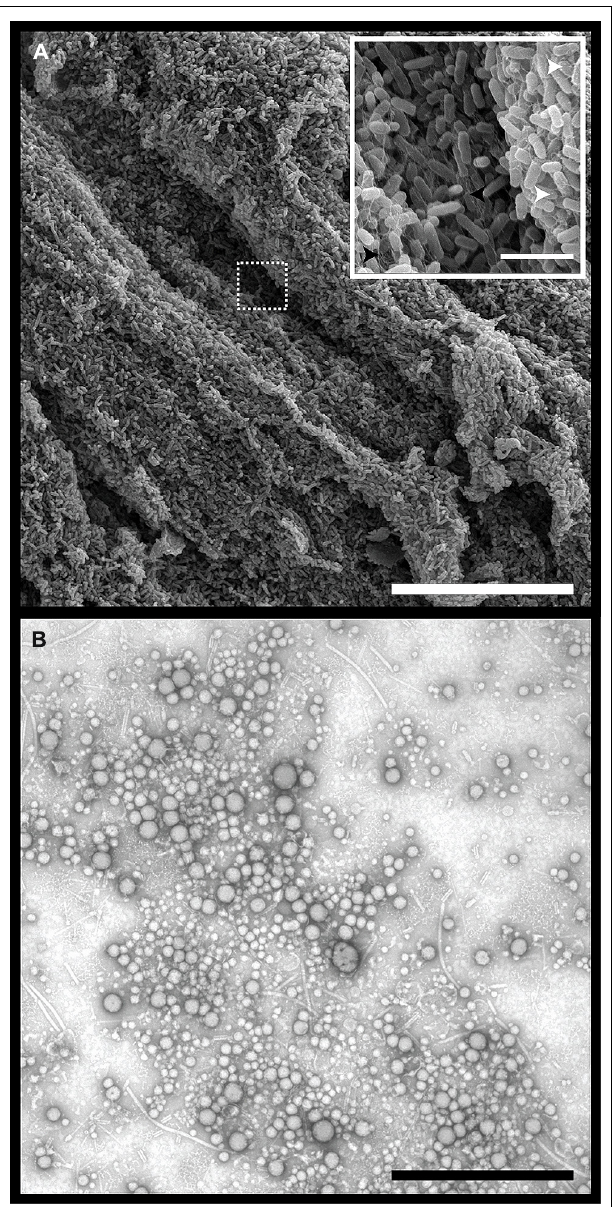
FIGURE 2 | Pseudomonas aeruginosa biofilms contain densely packed whole cells, self-produced matrix material, and extracellular outer membrane vesicles (OMVs). (A) Scanning electron micrographs of P. aeruginosa PAO1 grown on tryptic soy agar for 24 h. Dashed box indicates area of magnification. Scale bars represent 30 μ m (main) and 3 μ m (inset). Inset symbols:White arrowheads indicate OMVs on the surface of whole cells. Black arrowheads indicate dehydrated extracellular matrix material. (B) Transmission electron micrograph of negatively stained OMVs purified from a 24 h P. aeruginosa biofilm. Scale bar represents 1 μ